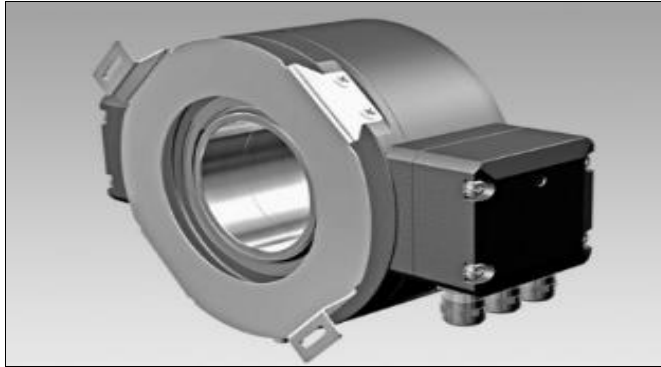
Figure 8: Absolute